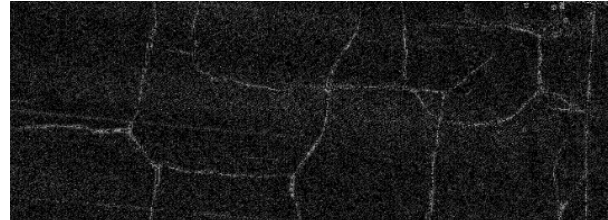
Figure 6. Illustration of the derived DTM high-pass convolution result.